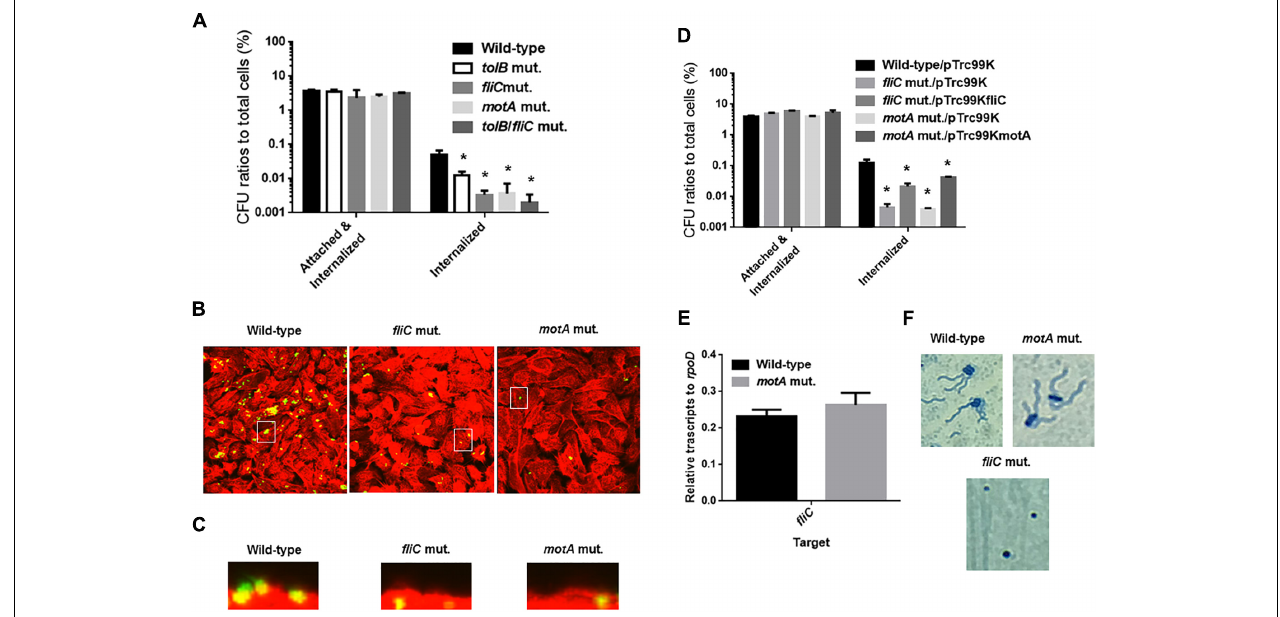
FIGURE 6 | Adhesion to, internalization of and aggregation within bladder epithelial cells (HTB-9) for the wild-type parent, and the tolB , fliC , and motA mutants, or wild-type parent and mutants carrying pTrc99K (empty vector), pTrc99KfliC ( fliC expression plasmid) or pTrc99KmotA ( motA expression plasmid). Y -axis on the graphs shows percent (%) of CFU (colony forming units) values of adhered and internalized bacteria relative to total bacterial cell numbers (A,D) . Data plotted are the means from three independent experiments; error bars indicate the standard deviations ∗ P < 0.01. Asterisks denote significance for values relative to the wild-type control. Fluorescent images of aggregated UPEC cells within bladder epithelial cells (HTB-9). Bacteria carrying a Green fluorescence protein (GFP) expression plasmid, pTurboGFP-B and HTB-9 stained with rhodamine-phalloidin were imaged as, respectively, green and red fluorescent colors on the microscopy using 60 × objective. Overlooking images (B) and cross sectional images in the white box indicated in panel B (C) were acquired for each sample. The experiment was repeated twice and similar results were obtained. Transcript levels of fliC gene in the wild-type parent and the tolB mutant (E) . Transcript levels were described as relative values to that of rpoD (housekeeping gene). Data plotted are the means of two biological replicates, error bars indicate the ranges. Flagella and bacteria cells stained with Victoria blue/Tannic acid were pictured on the microscopy using 100 × objective (F)